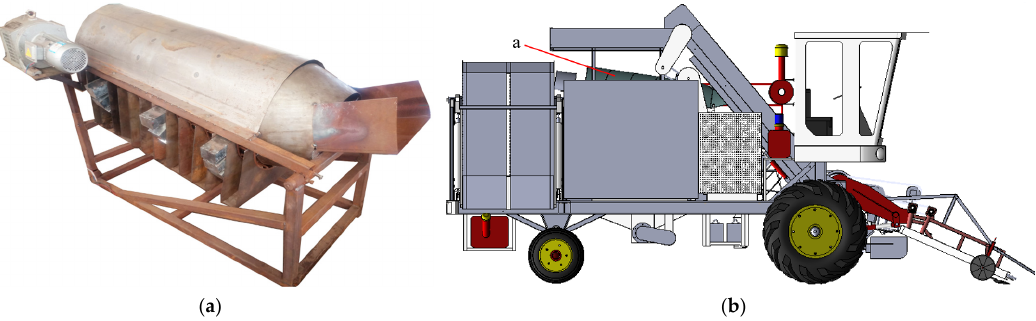
Figure 7. Peanut pod-picking device. ( a ) Peanut root disk full-feeding longitudinal axial flow pod- picking device. ( b ) Combine harvester for both peanut seedlings and peanuts (a is the Peanut root disk full-feeding longitudinal axial flow pod-picking device).